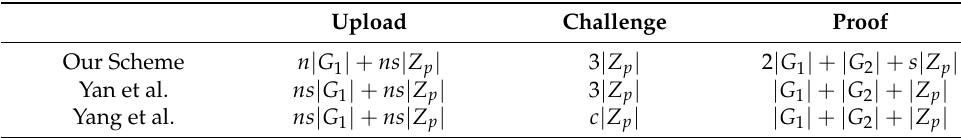
Table 3. Comparison of communication